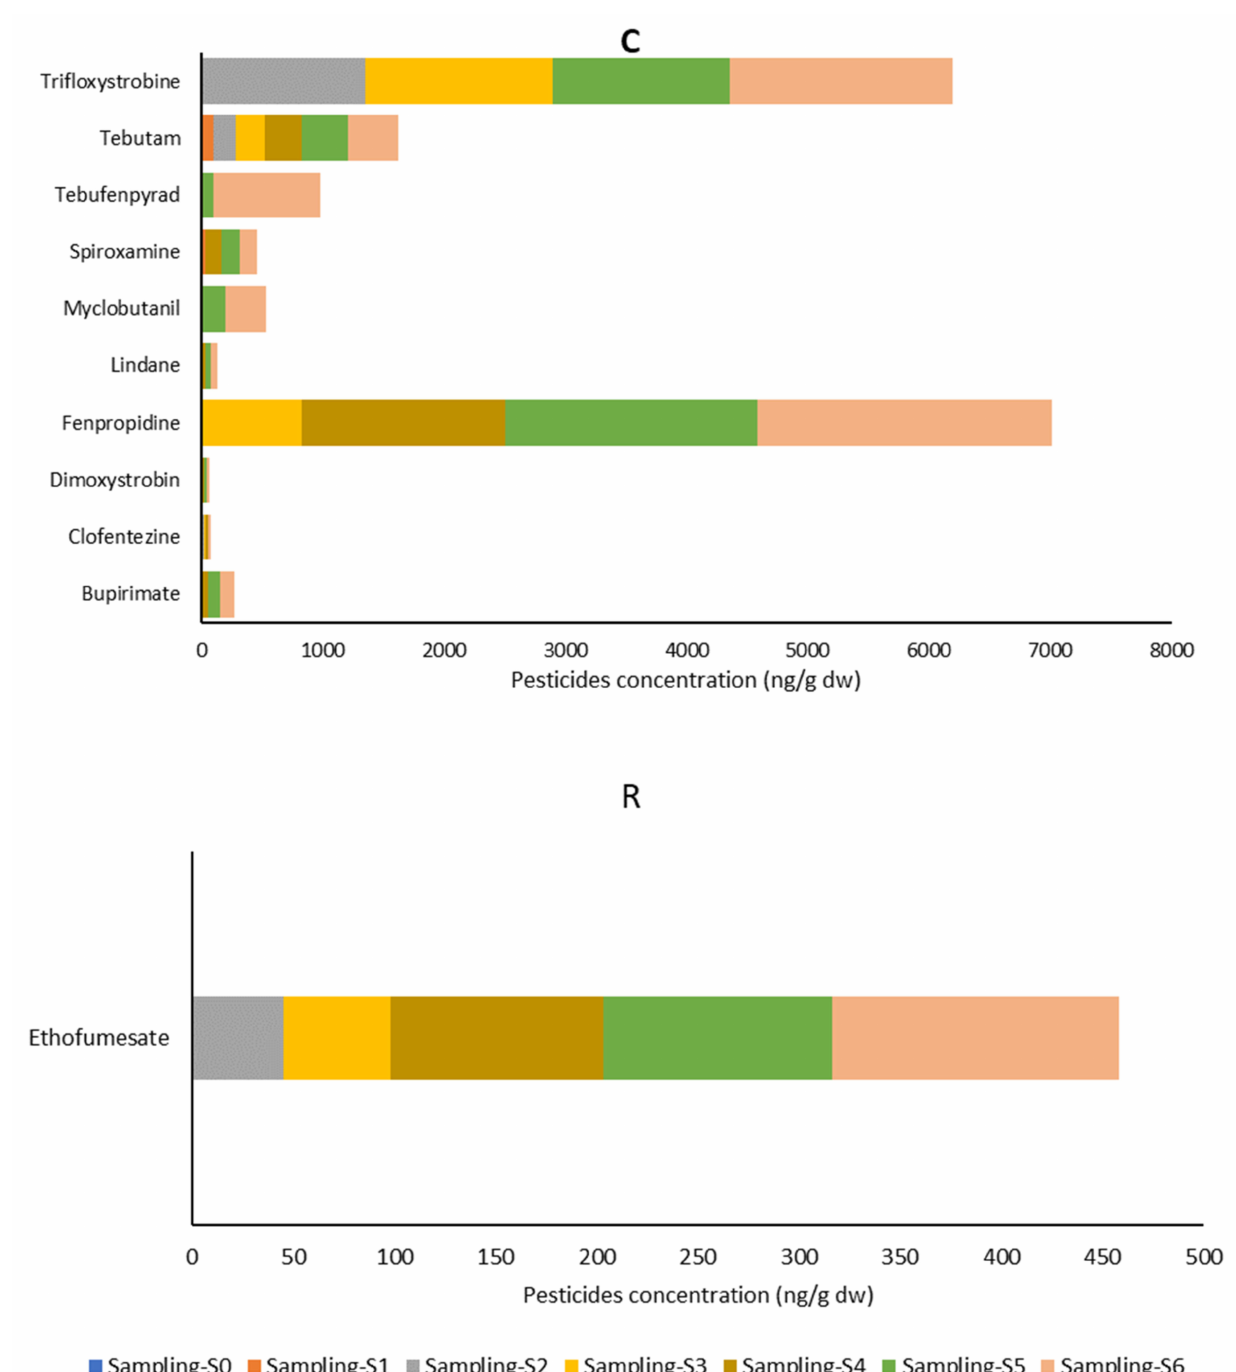
Figure 4. Concentration of semi volatile pesticides (ng/g dw) in the snails sampled from the four sampling sites, A: site-A, B: Site-B, C: Site C and R: